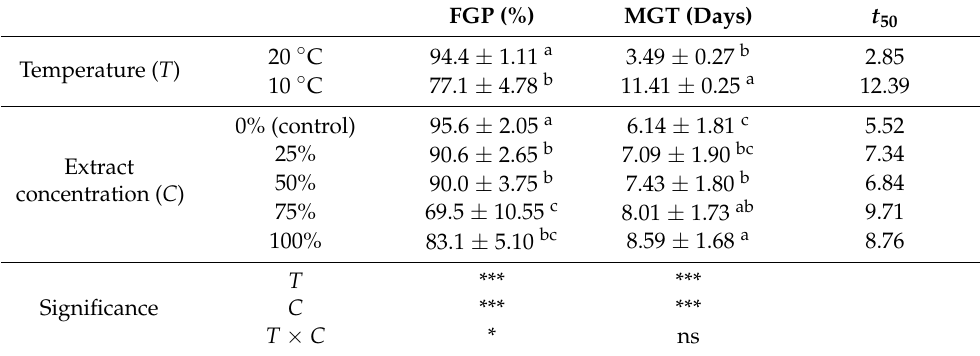
Table 4. Main effects of temperature and hemp leaf extract concentrations on final germination percent- age (FGP), Mean germination time (MGT), and time to 50% germination ( t 50 ), in wheat cv. Mongibello.